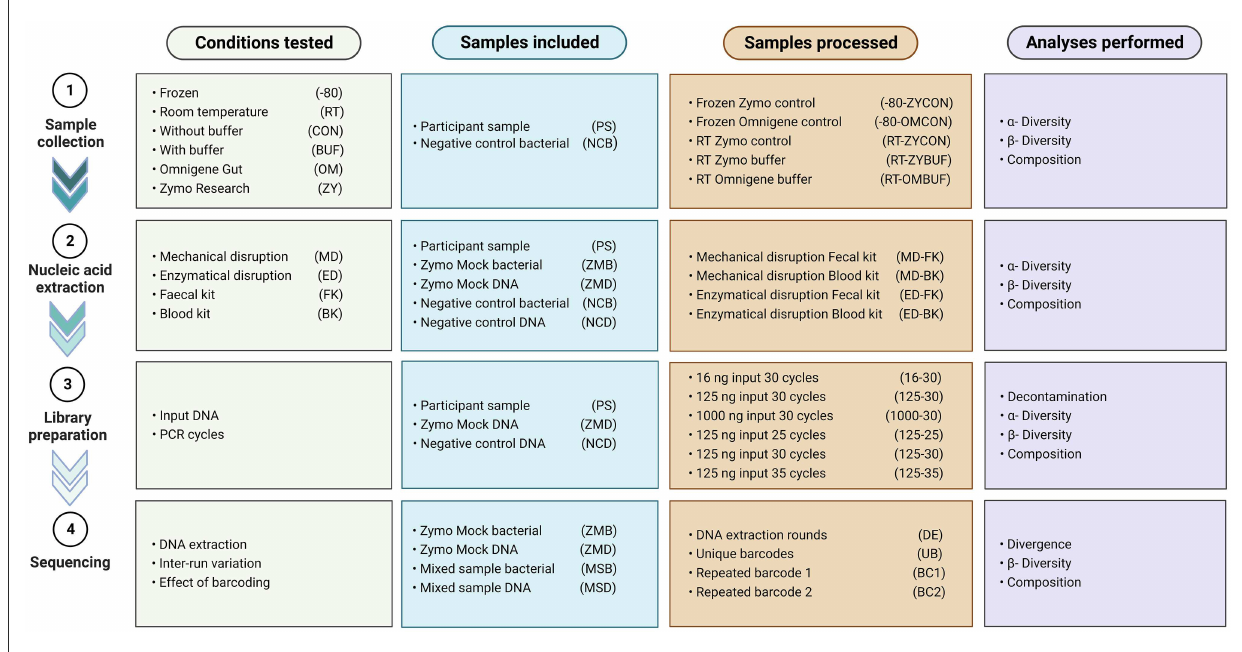
FIGURE1 Overview of the conditions tested, samples included and processed in every experiment, and analyses performed.